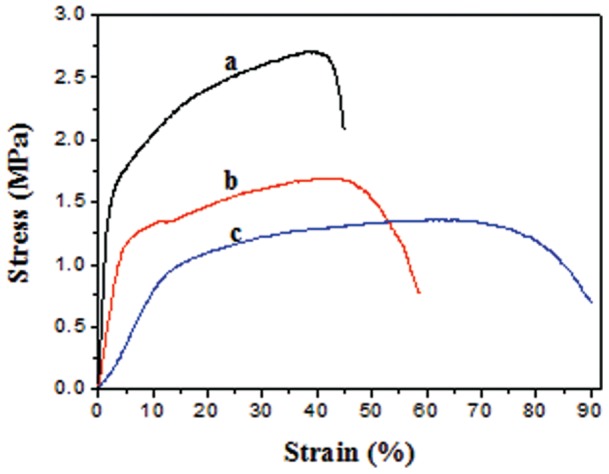
Tensile stress–strain curves of the electrospun NFS: (a) 3/1 NFS, (b) 2/1 NFS, and (c) 1/1 NFS.As the PCL content increased, Young’s modulus and tensile strength decrease. However, its elongation at break increases.